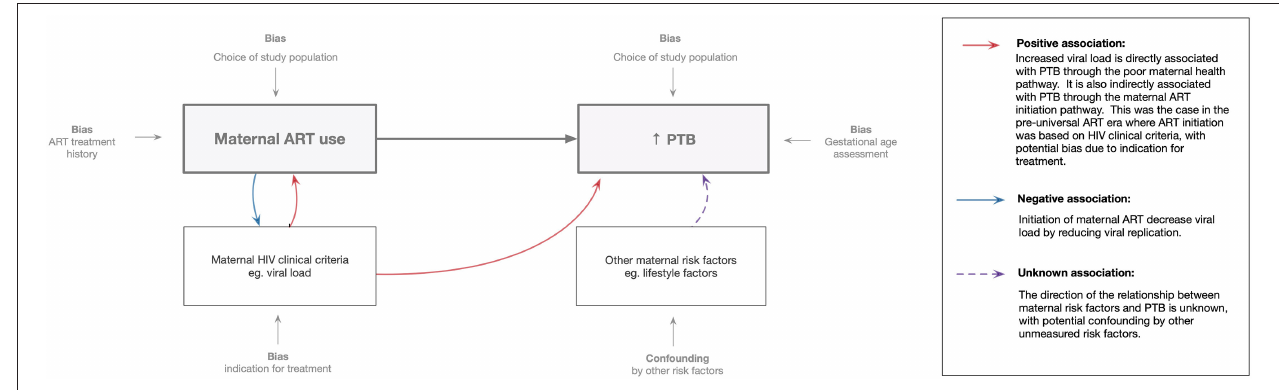
FIGURE 1 | Methodological perspective: association between maternal ART use and preterm birth. Maternal ART use assessment is influenced by treatment history (including timing of initiation and ART regimens used) and study population chosen. Preterm birth assessment is influenced by the accuracy of gestational age measurement and the study population (i.e., trimester of inclusion of women in the